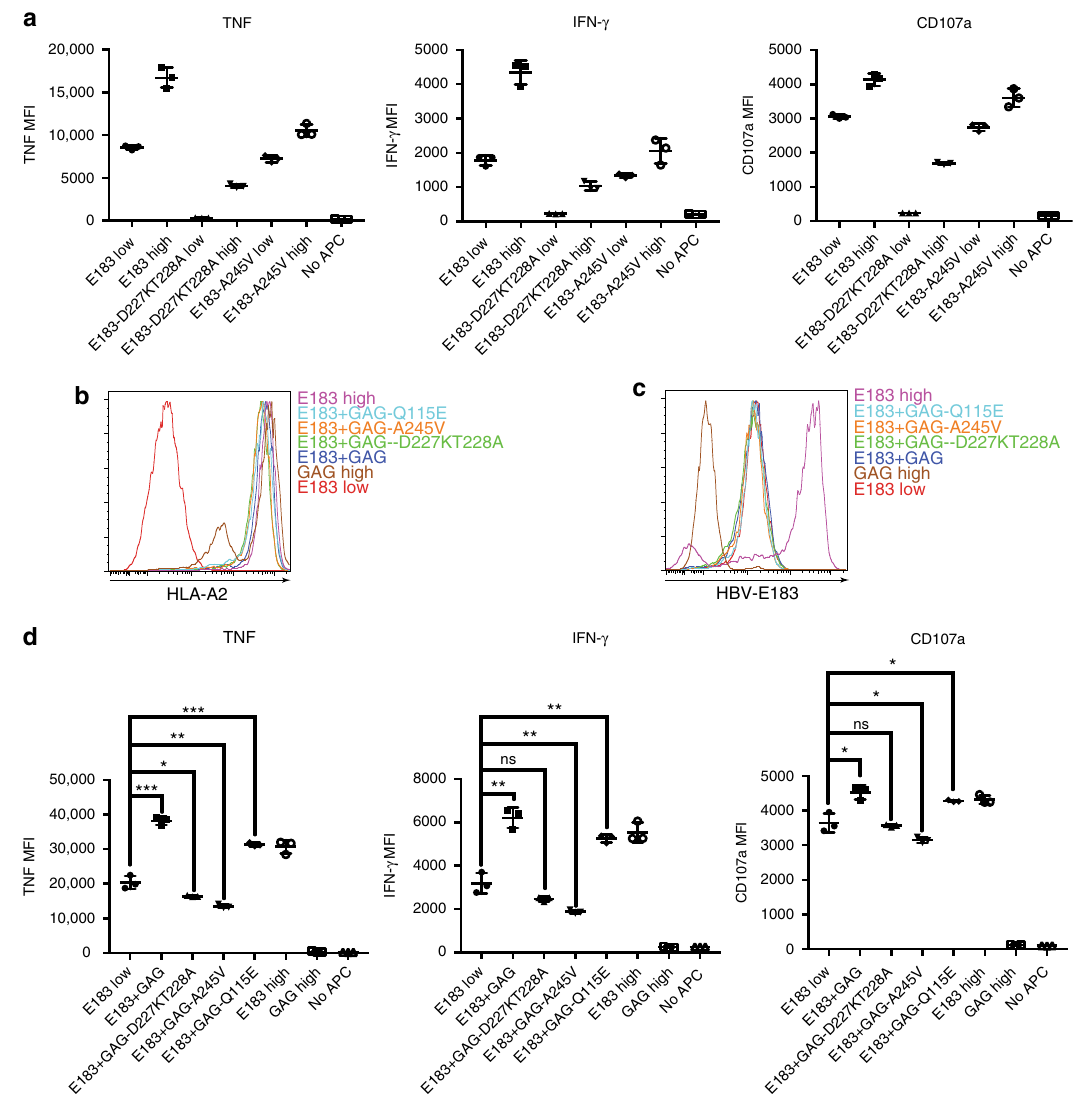
Fig. 3 CD8 binding to nonstimulatory pMHCI is required for coagonism in human T cells. a D227K, T228A, or A245V mutations were introduced in the antigen sc E183-HLA-A2 (sc E183-HLA-A2-CD8mut). Doxycycline-inducible sc E183-HLA-A2-CD8mut constructs were transfected into T-REx CHO cells. Single cell clones were used to stimulate human E183 CTL for 3 h. Cytokine production (TNF and IFN- γ ) and upregulation of the degranulation marker CD107a in E183 CTL were assessed by fl ow cytometry. b D227K, T228A, A245V, or Q115E mutations were introduced in the nonstimulatory sc GAG-HLA- A2 (sc GAG-HLA-A2-CD8mut). sc GAG-HLA-A2-CD8mut constructs were transfected into the T-REx CHO clone that could simultaneously express low concentration of the antigen sc E183-HLA-A2 and single cell clones were sorted. Anti-HLA-A2 staining ( b ) or anti-E183-HLA-A2 staining using TCR-like antibody ( c ) was performed on the indicated T-REx CHO clones. d Human E183 CTL were cultured with the indicated T-REx CHO cells for 3 h and cytokine production (TNF and IFN- γ ) and upregulation of the degranulation marker CD107a were assessed by fl ow cytometry. Statistical signi fi cance was determined by using unpaired two-sided Student ’ s t test and shown as mean ± s.d. (ns nonsigni fi cant, * p < 0.05, ** p < 0.01, *** p < 0.001, **** p <